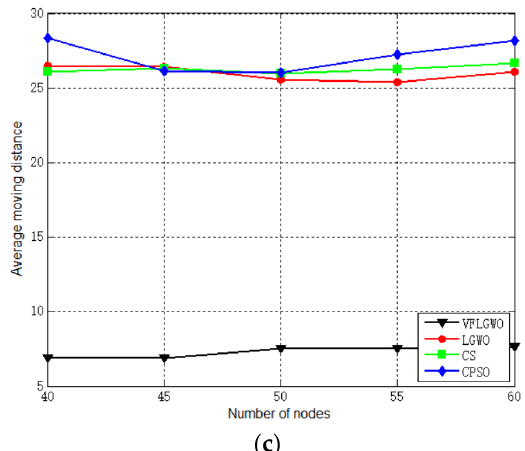
Figure 7. Performance index of the four algorithms with different numbers of sensor nodes. ( a ) Coverage rate of the four algorithms. ( b ) Uniformity of the four algorithms. ( c ) Average moving distance of the four algorithms.